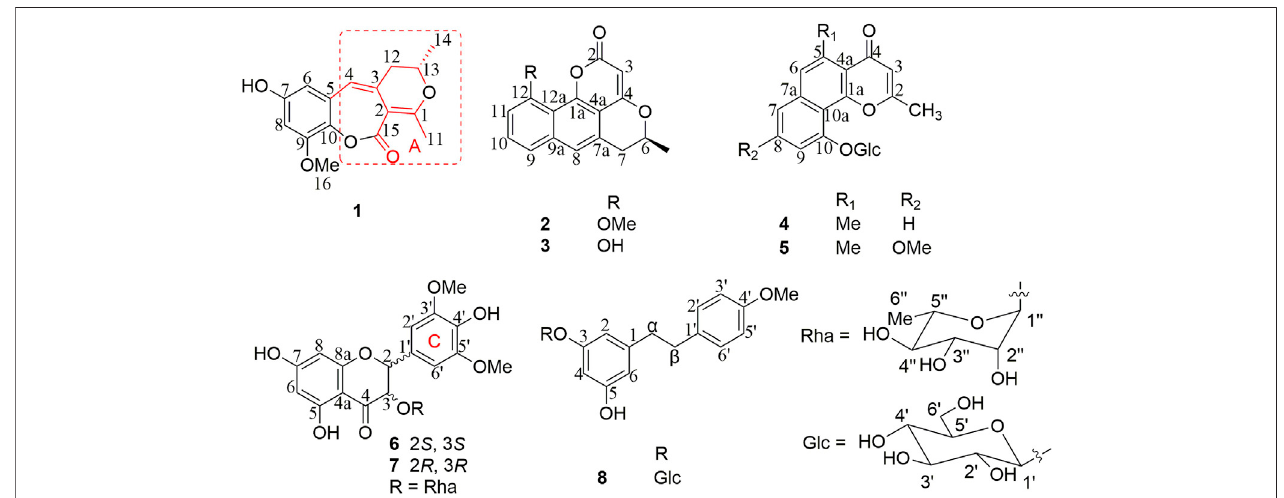
FIGURE 1 | New phenolic compounds 1 – 8 from Berchemia lineata (L.)